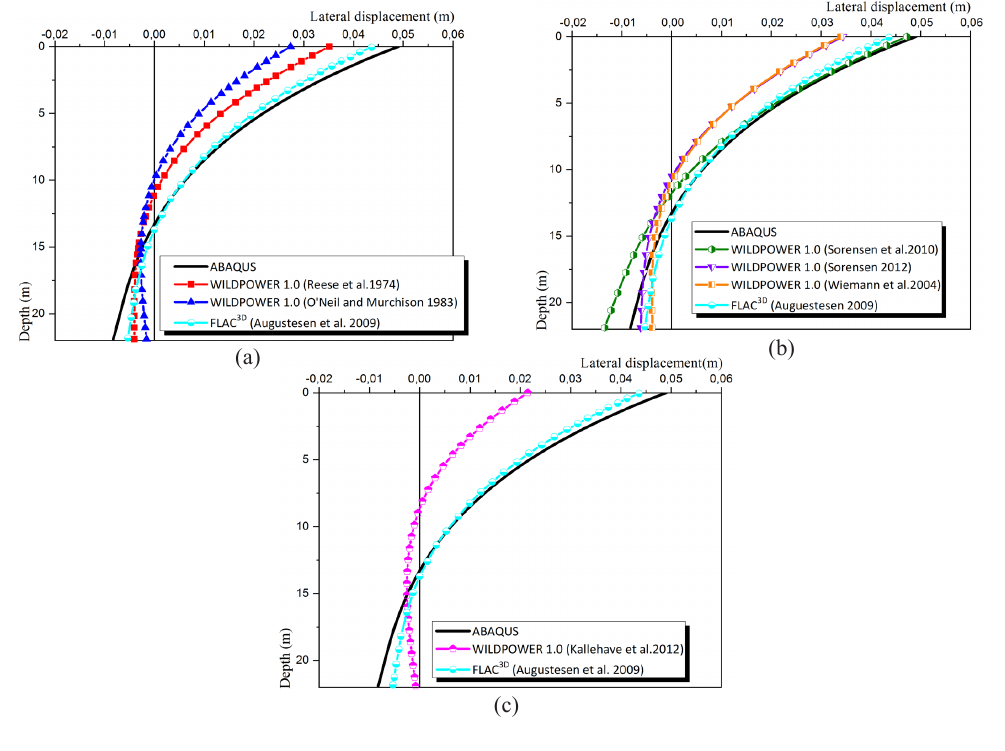
Figure 4: Profiles of lateral displacements.